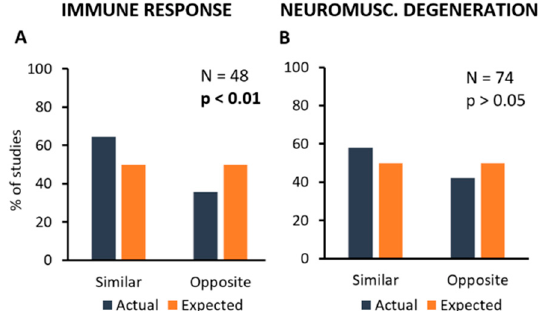
Figure 5. Frequency distribution of the primary studies showing the association between treatments and the mechanisms they can modify. In particular, the most frequent types of mechanism, i.e., Immune Response ( A ) and Neuromuscular Degeneration ( B ) have been considered. Percent number of experiments showing the modification of one of these mechanisms (in blue) are compared to the expected values (null hypothesis, in orange). Each graph shows the total number of experiments analysing a particular mechanism, and the p -value calculated by using the Chi-square statistical test.